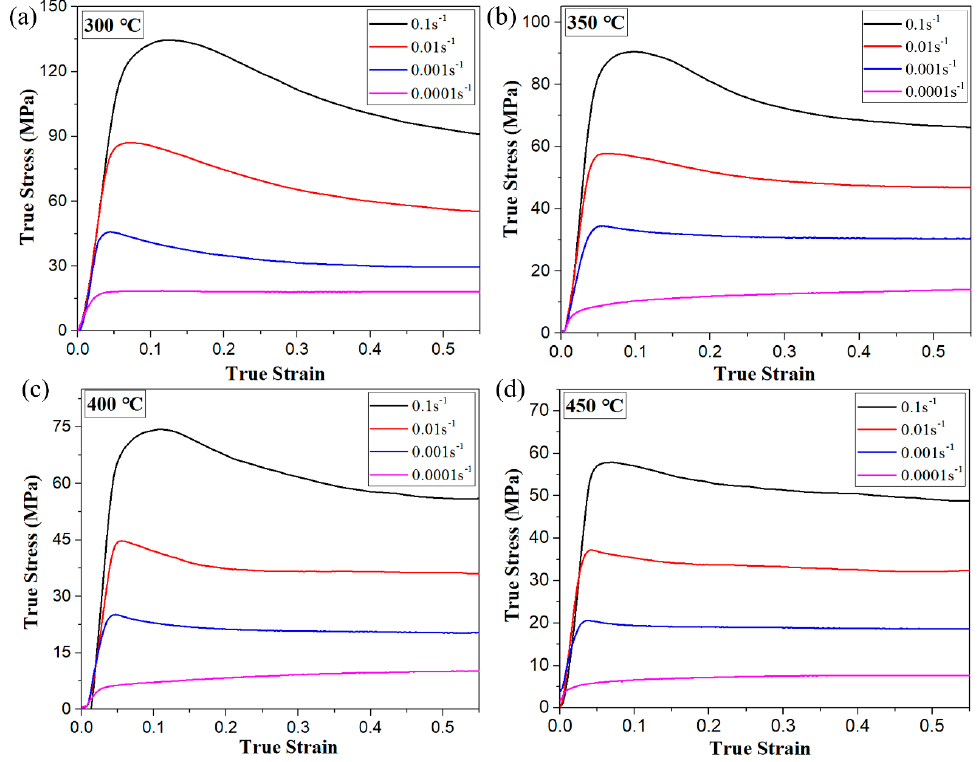
Figure 2. Flow stress–strain curves of nanohybrid/AZ80 composite under different compression conditions: ( a ) 300, ( b ) 350, ( c ) 400, and ( d ) 450 °C.